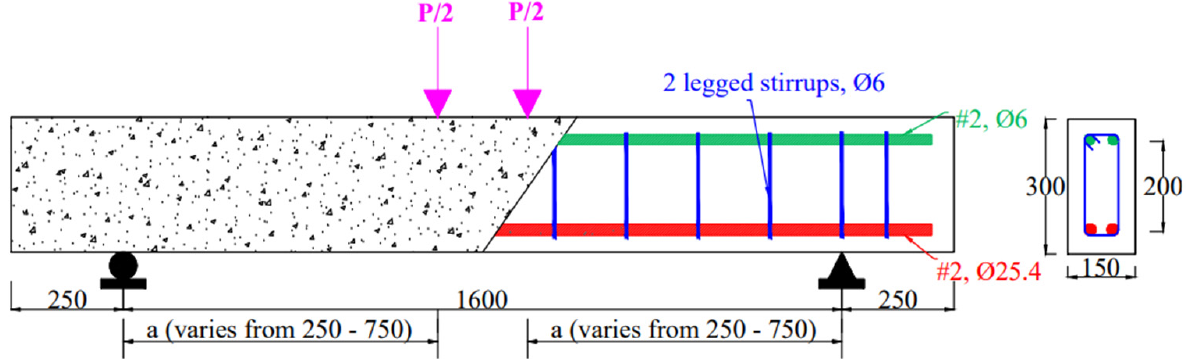
Figure 12. Dimensions of the ECC beam used for parametric analysis (note: all dimensions are in mm).